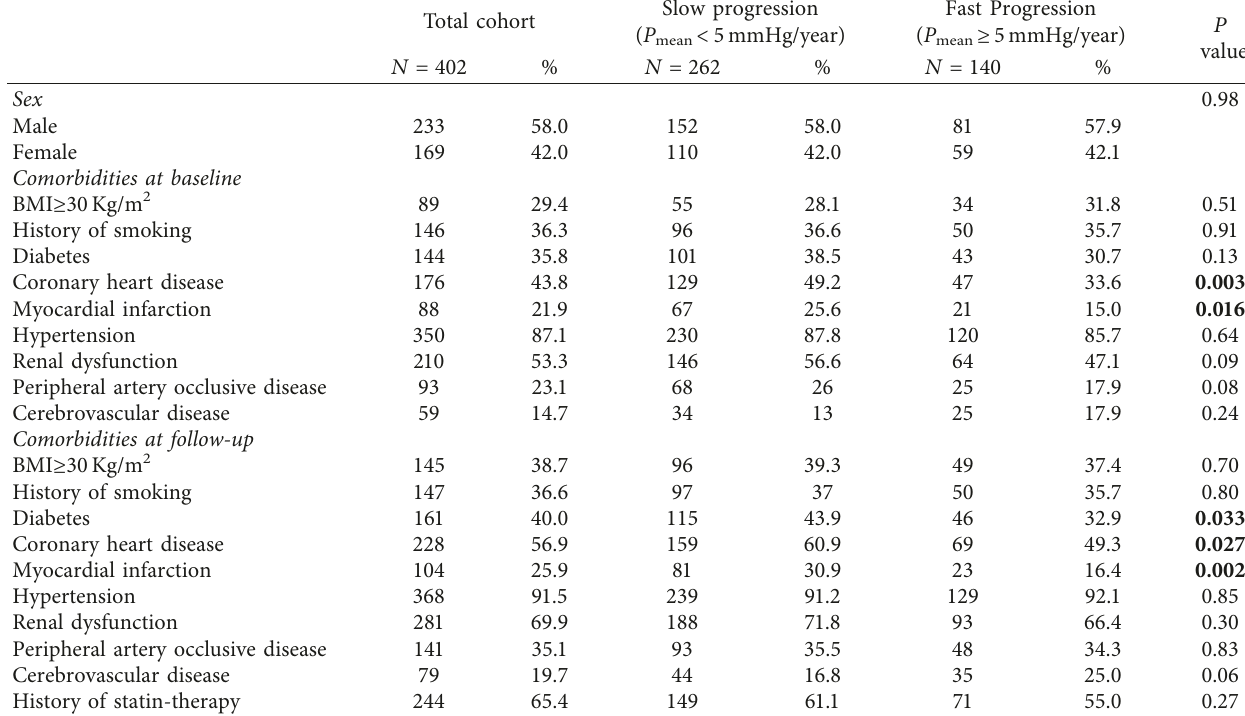
Table 2: Comorbidities of patients with slow or fast progression of mean transaortic pressure gradient at baseline and follow-up echocardiography.